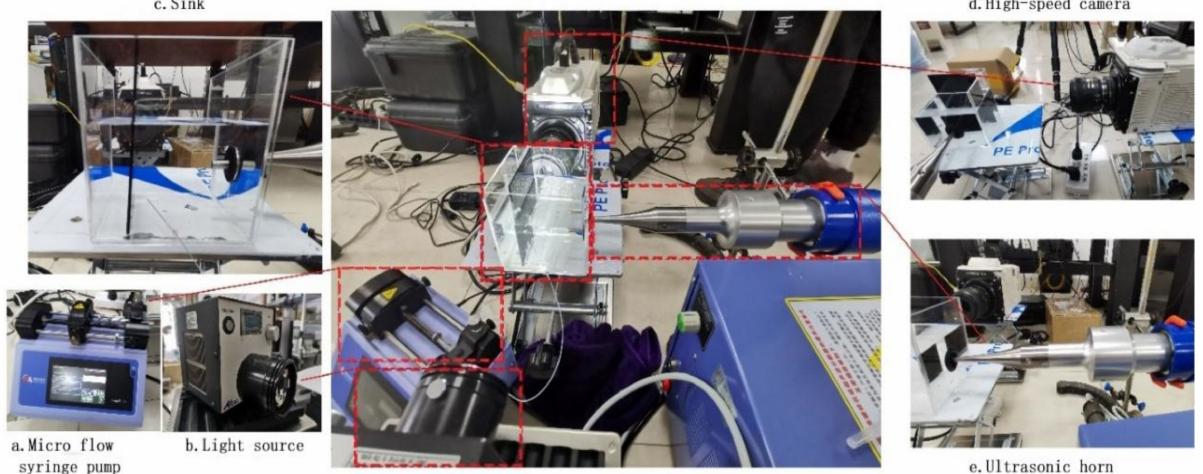
Figure 6. Experimental platform for ultrasonic cavitation observation of bubbles near the wall. ( a ) microfluidic syringe pump; ( b ) light source; ( c ) water tank; ( d ) high-speed camera; ( e ) ultra- sonic